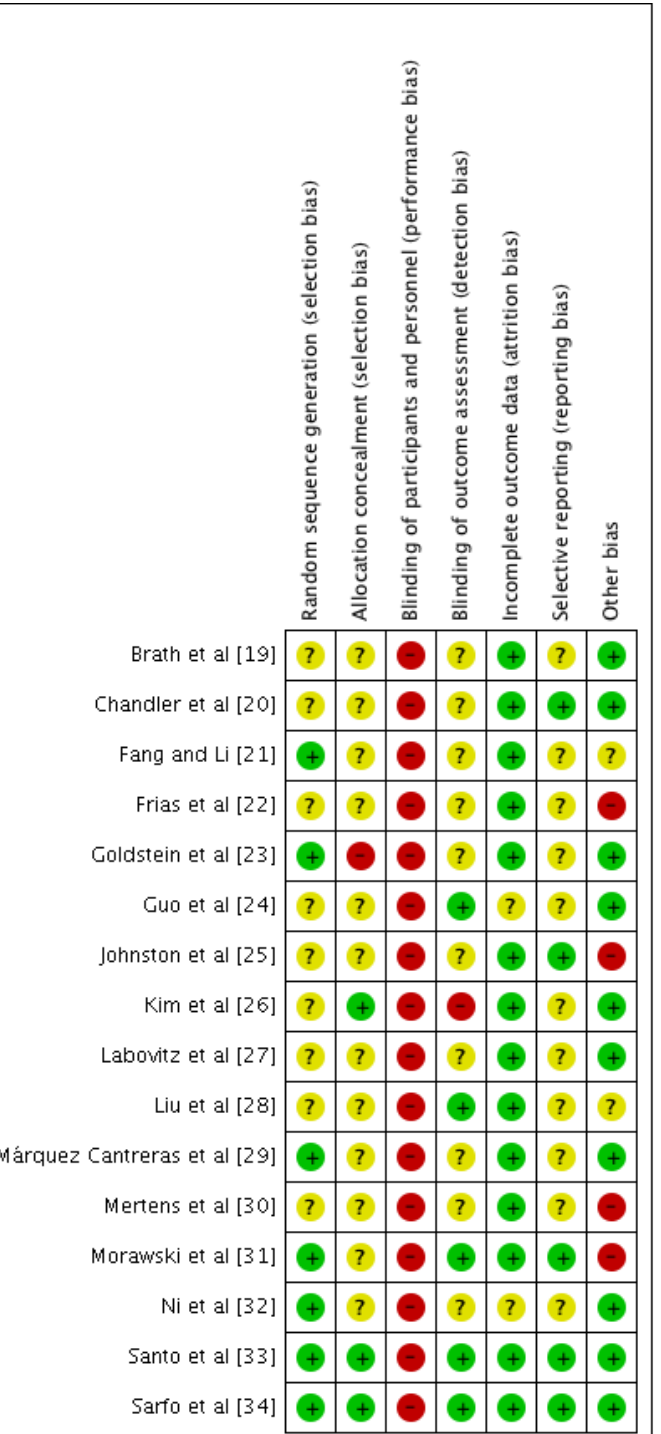
Figure 3. Authors’ judgments about each risk of bias item for each included trial. Green: low risk of bias; yellow: unclear risk of bias; red: high risk of